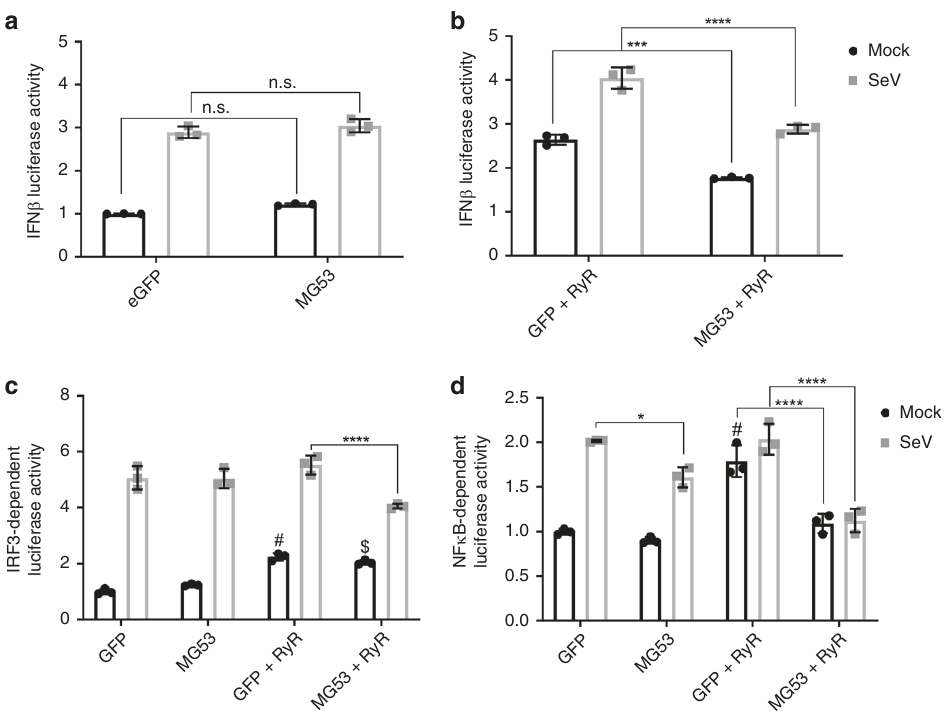
Fig. 7 MG53-mediated suppression of IFN β transcription is RyR-dependent. a HEK293 cells were transfected with IFN β luciferase and control Renilla luciferase reporters in addition to GFP or MG53 expression constructs. Cells were then either mock treated or infected with SeV (MOI 5) for 8 h. Overexpression of MG53 did not signi fi cantly affect IFN β Luciferase activity with (gray) or without SeV infection (black) (data representative of three independent experiments; mean ± SD; n.s. means nonsigni fi cant; two-way ANOVA with Sidak ’ s multiple comparison test). b HEK293 cells expressing RyR2 were used to assess IFN β luciferase activity. Cells were transfected with luciferase reporters in addition to either GFP or MG53 expression constructs. Cells were mock treated or infected with SeV. MG53 signi fi cantly suppresses luciferase activity in HEK293 cells expressing RyR (data representative of three independent experiments; mean ± SD; *** p = 0.0002, **** p < 0.0001; two-way ANOVA with Sidak ’ s multiple comparison test). c Overexpression of MG53 suppresses SeV-induced IRF3 transcriptional activity when RyR is coexpressed (data have been normalized to mock GFP group and is representative of three independent experiments; mean ± SD; **** p < 0.0001, “ $ ” denotes p = 0.0016 relative to mock GFP, “ # ” denotes p = 0.0002 relative to mock GFP; two-way ANOVA with Sidak ’ s multiple comparison test). d Under mock and infected conditions, overexpression of MG53 suppresses the agonistic effect of RyR on NF κ B reporter activity (data have been normalized to mock GFP group and is representative of three independent experiments; mean ± SD; * p = 0.0148, **** p < 0.0001, “ # ” denotes p < 0.0001 relative to mock GFP; two-way ANOVA with Sidak ’ s multiple comparison